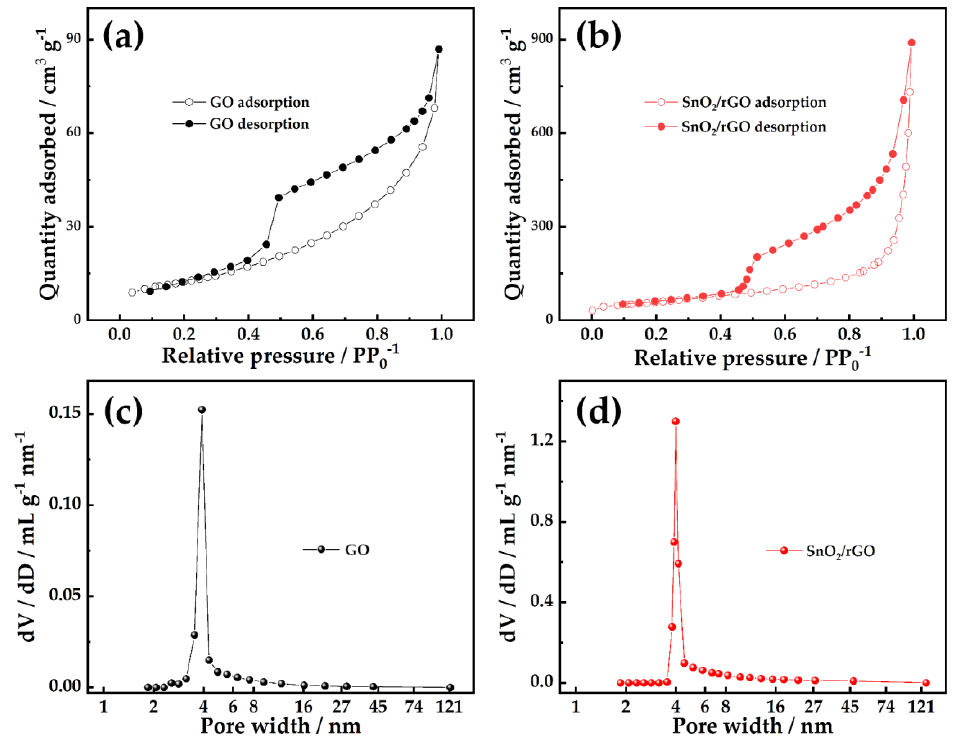
Figure 3. ( a ) N 2 adsorption – desorption isotherms of GO; ( b ) SnO 2 /rGO; ( c ) pore-size distributions of GO; ( d ) SnO 2 /rGO based on BJH model.